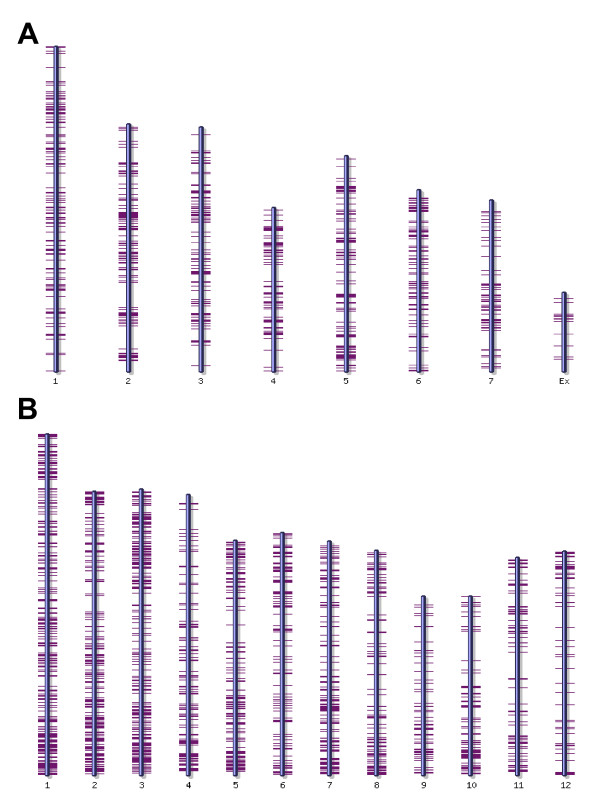
Genome wide distribution of infection ESTs. EST sequences were mapped to M. oryzae (A) or rice (B) chromosomes.